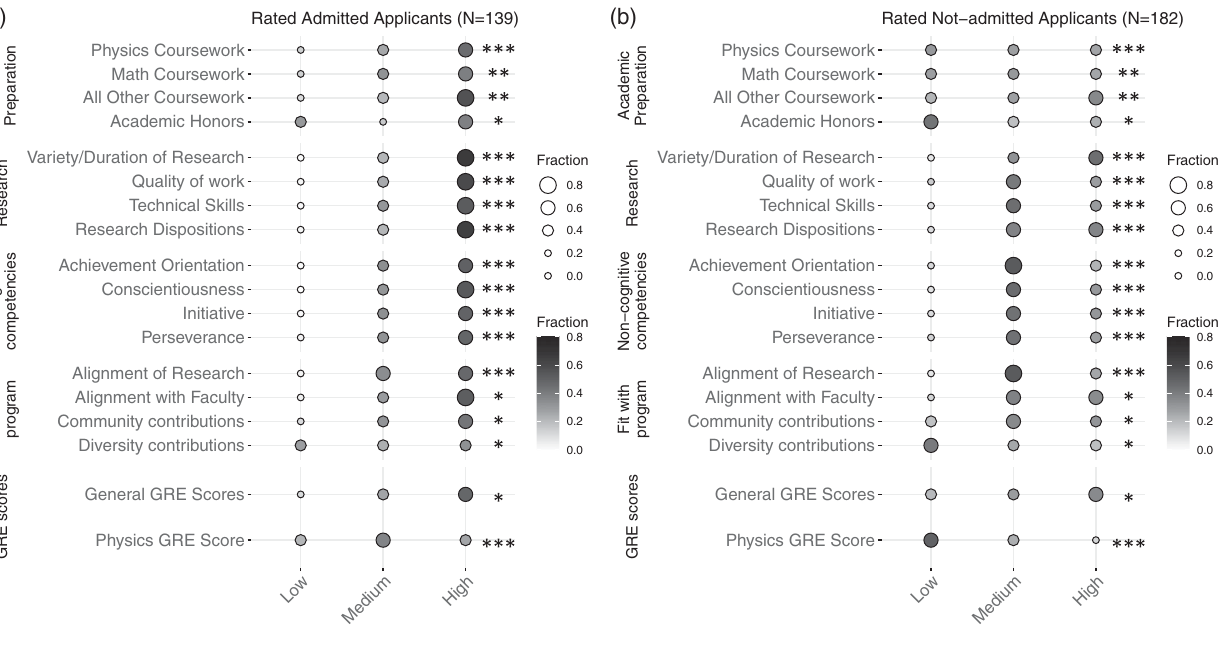
FIG. 2. Faculty ratings of domestic applicants on 18 constructs split by whether the applicant was admitted. Ratings that are statistically different between the two plots are marked on the right side of the plot, with a corrected p value < 0 . 001 represented by “ ***, ” < 0 . 01 by “ **, ” and < 0 . 05 by “ *. ” The distribution of ratings of all constructs is statistically different for admitted applicants compared to nonadmitted applicants. Overall, most admitted applicants were rated “ high ” while most nonadmitted applicants were rated “ medium ”